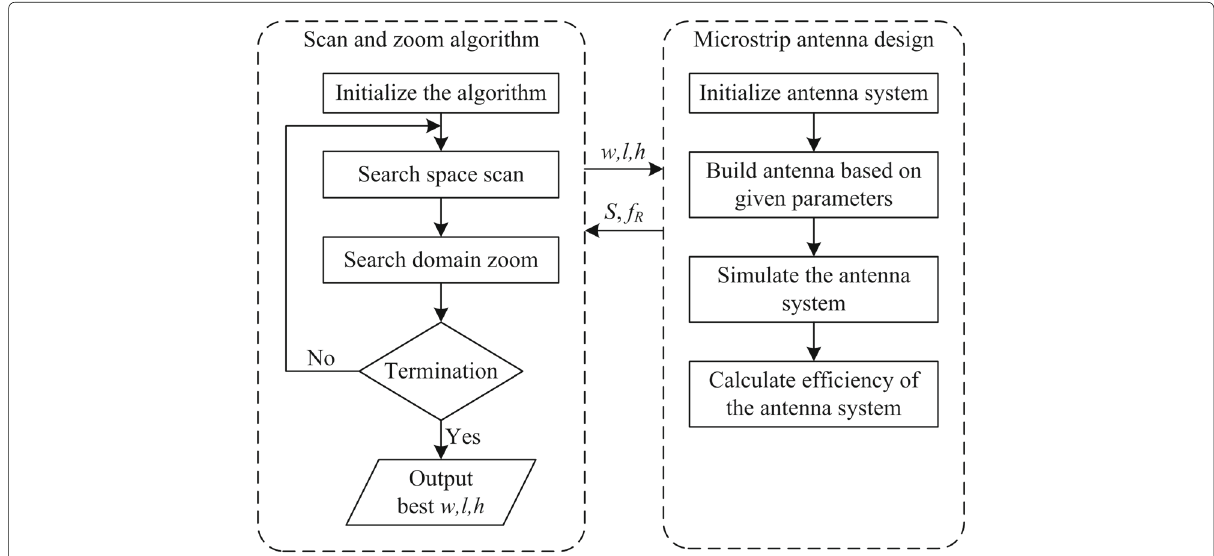
Fig. 3 The proposed optimization framework for microstrip antenna